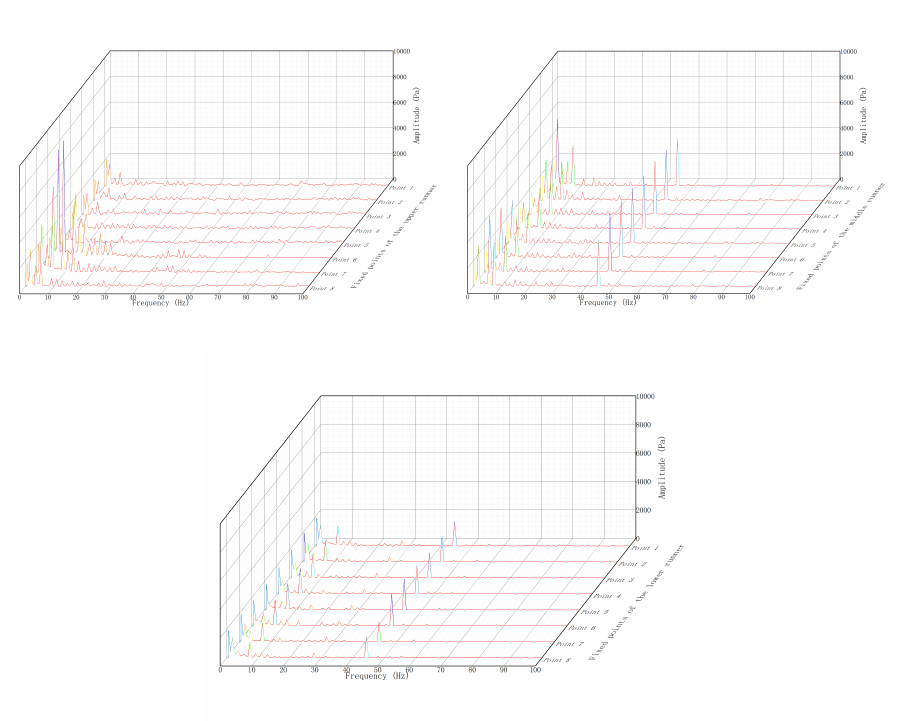
Figure 24. The pressure fluctuations of the upper, middle, and lower